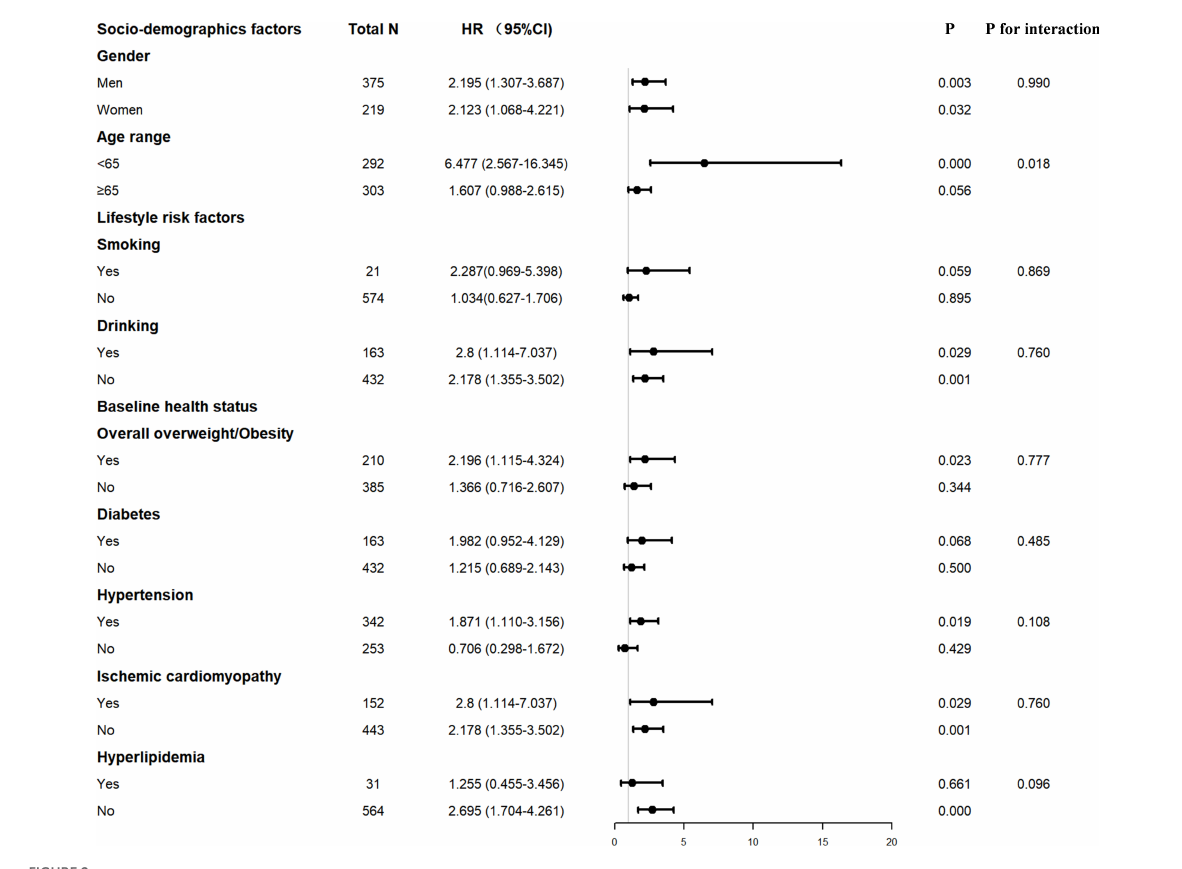
FIGURE2 Interaction of confounding factors on the association between (cid:49) PNI and major adverse cardiovascular event (MCE) risk. PNI, prognostic nutritional